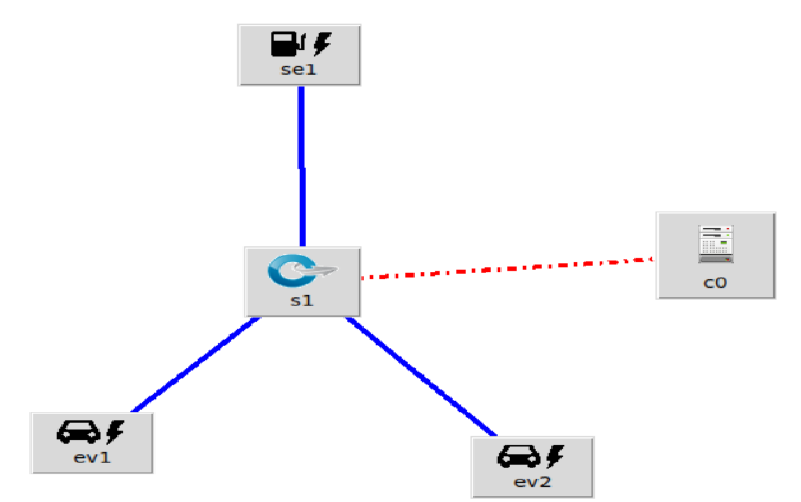
Figure 1. Attack-free simulation architecture.